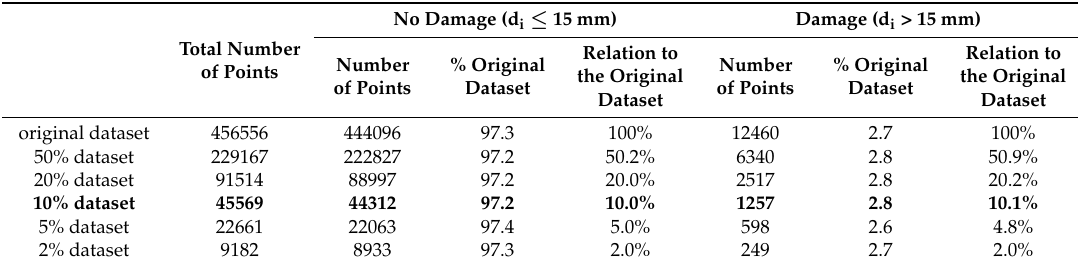
Table 4. Results of processing with the random method—brick